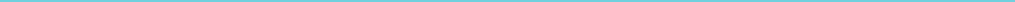
Figure 2: Current indications for SGLT2 inhibitors in patients with type 2 diabetes mellitus and established cardiovascular disease, high car- diovascular risk, heart failure or chronic kidney disease.ASCVD = atherosclerotic cardiovascular disease; CKD = chronic kidney disease; CV = cardiovascular; CVD = cardiovascular disease; CVOTs = cardiovascular outcomes trials; DPP-4i = dipeptidyl peptidase 4 inhibitor; eGFR = es- timated glomerular filtration rate; GLP-1 RA = glucagon-like peptide 1 receptor agonist; HF = heart failure; SGLT2i = sodium–glucose cotrans- porter 2 inhibitor; SU, sulfonylurea; TZD, thiazolidinedione. Excerpt from the American Diabetes Association [Pharmacologic Approaches to Glycaemic Treatment: Standards of Medical Care in Diabetes—2020 , American Diabetes Association, 2020]. Copyright and all rights re- served. Material from this publication has been used with the permission of American Diabetes Association.